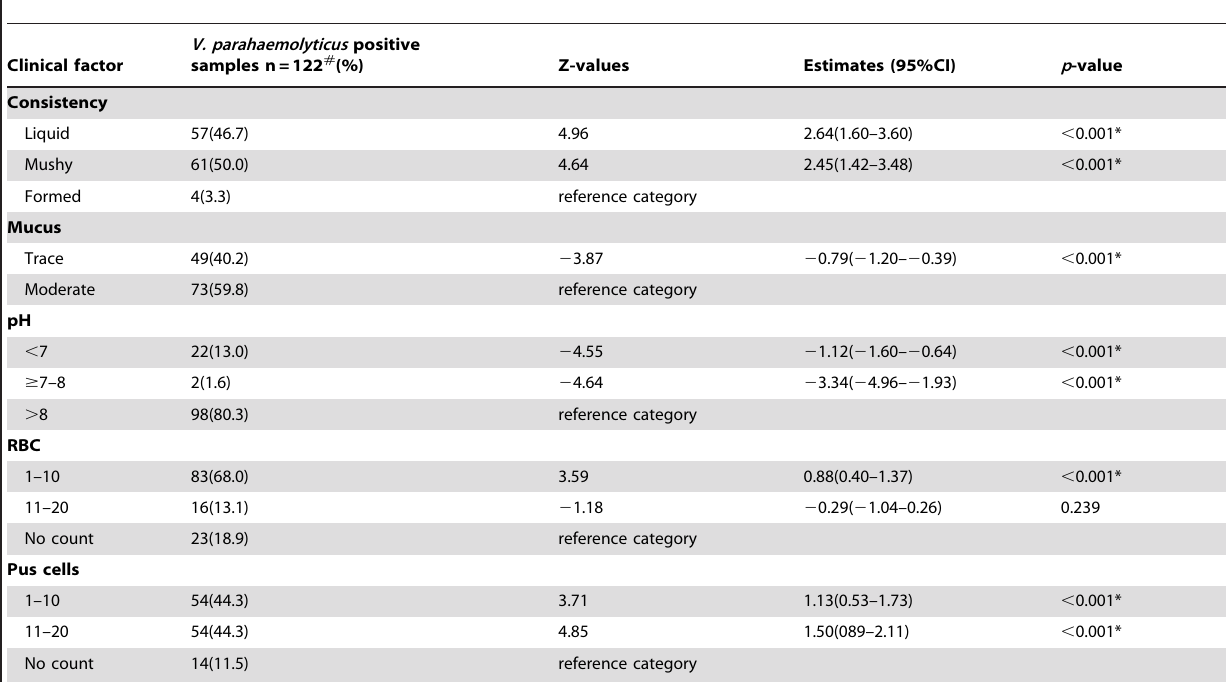
Table 3. General log-linear model analysis of stool characteristics with V. parahaemolyticus infection.